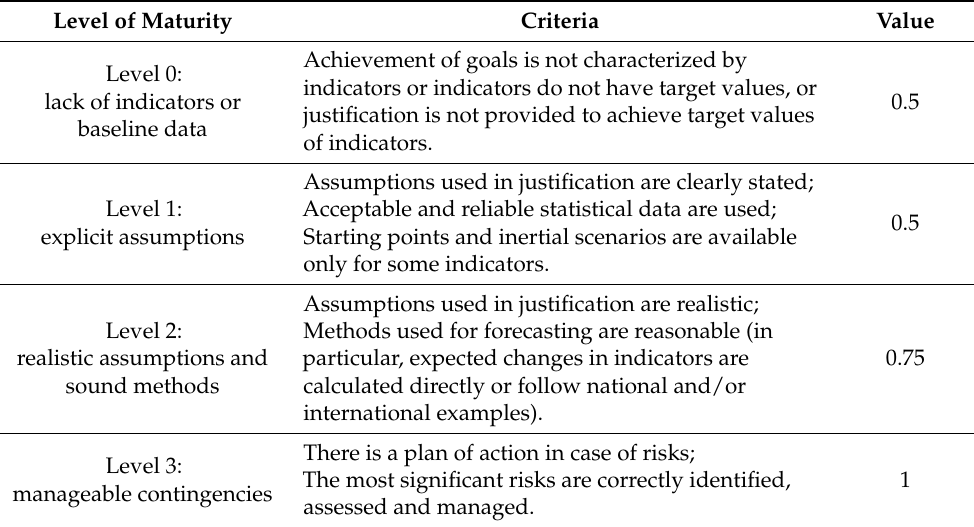
Table 3. Criteria for the maturity level of the